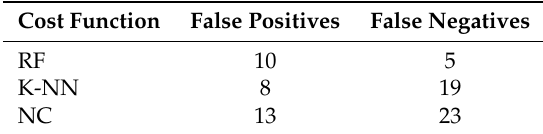
Table 4. Values comparison between the three cost functions: RF, K-NN, and